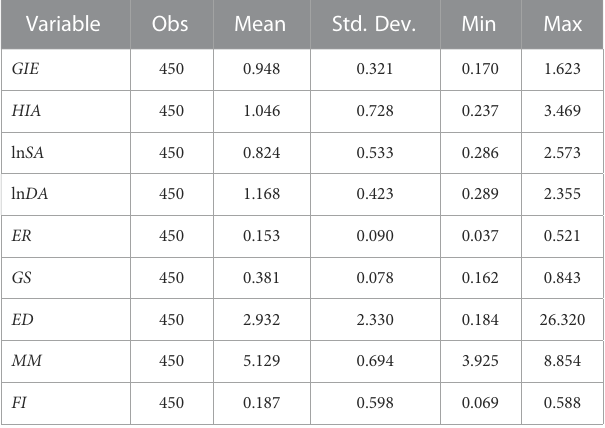
FIGURE 2 Distribution map of provinces in China.